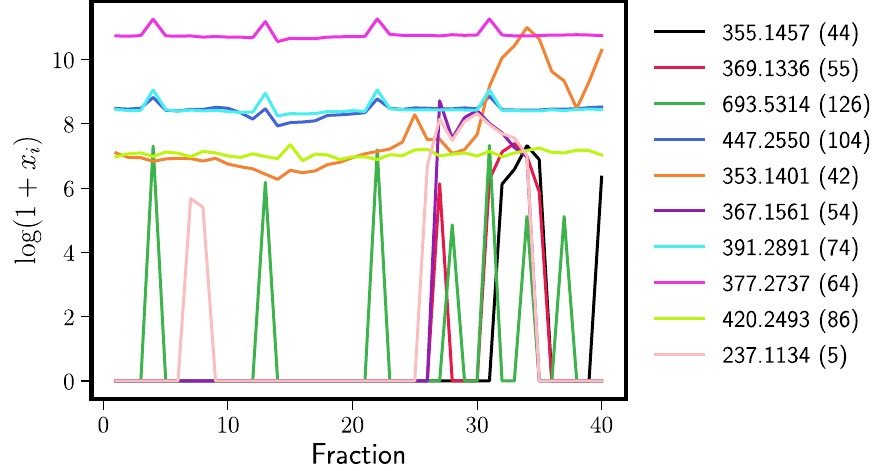
Figure 5. Chromatographic distribution and relative abundance of the top ten Elastic Net predictors of bioactivity across fractions. Color-coded ion currents are indicated by m / z values and by feature tags in parentheses. See Table 1 for compound names.